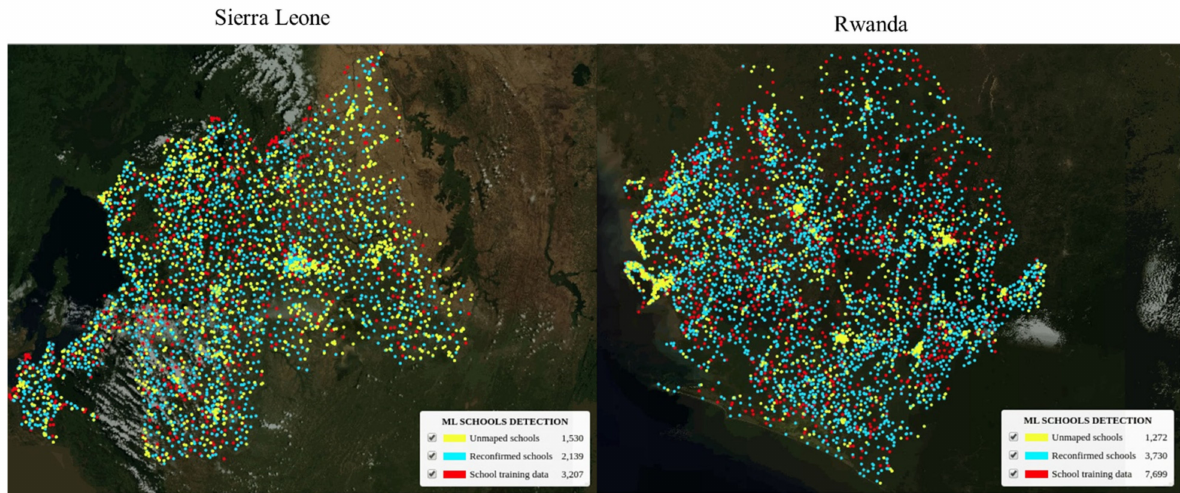
Figure 11. Map showing AI-discovered schools in Sierra Leone and